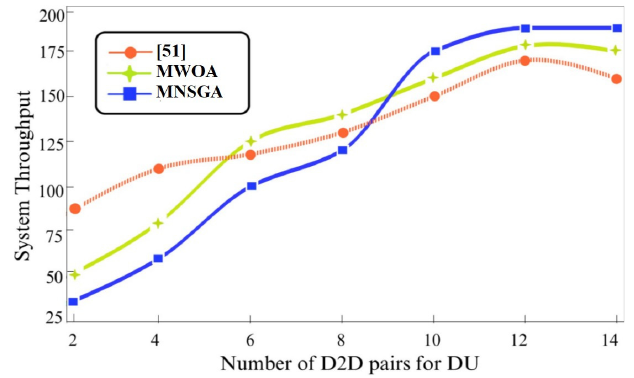
Figure 7. Throughputs for D2D pairs for DU s.